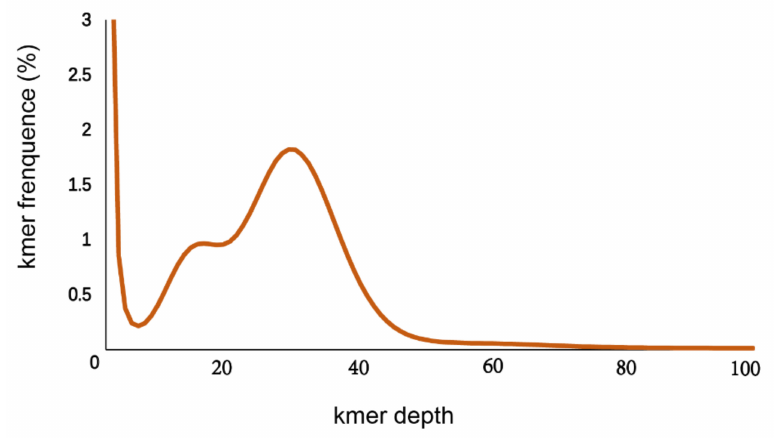
Figure 2. K-mer (19-mer) analysis for estimating the genome size of the shimofuri goby. Table 1. The genome result of assembly for the shimofuri goby using Illumina clean data.